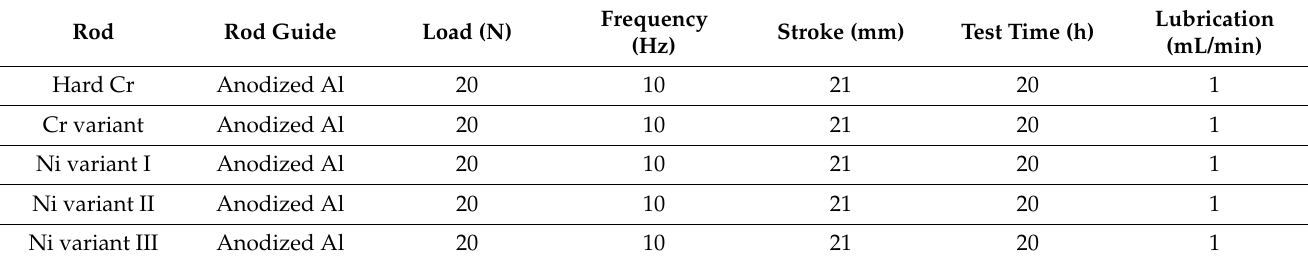
Figure 4. ( a ) Severe abrasion due to lack of lubrication between the rod and rod guide that leads to the formation of debris particles. ( b ) Formation of a tribo-layer due to adhesive wear on the rod. Table 1. Overview of tests performed with optimized experimental conditions for hydraulic cylinder